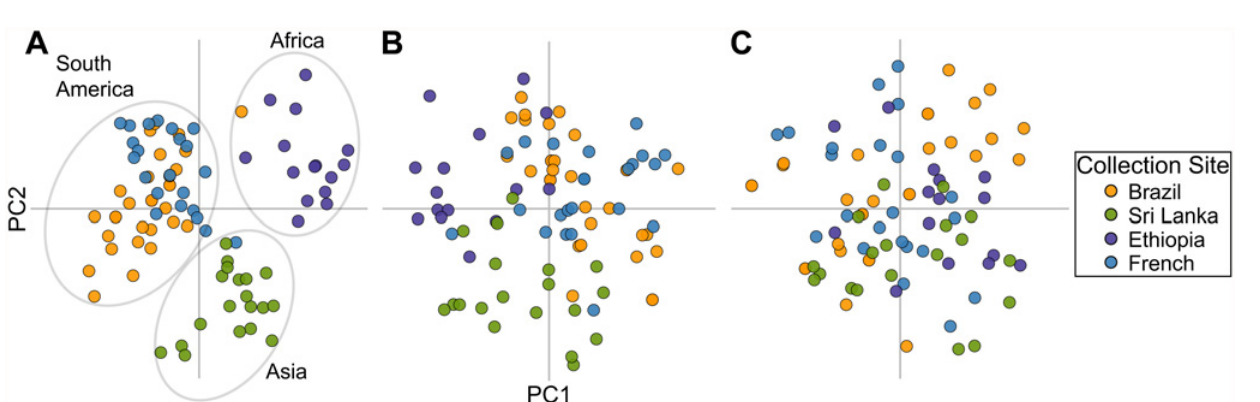
Fig 4. Barcodes with a reduced number of SNPs lose the ability to classify samples by geographic origin. PCA analysis of the global sample set, with samples colored by collection site. (A) The 42-SNP barcode shows separation by continent in PCA, and the three continental clusters are circled. Samples from South America appear to show substructure, with Brazil samples dividing into two distinct clusters, one of which overlaps the single cluster of samples from French Guiana. (B) A 28-SNP and (C) a 14-SNP barcode selected for maximal population diversity were unable to distinguish populations.